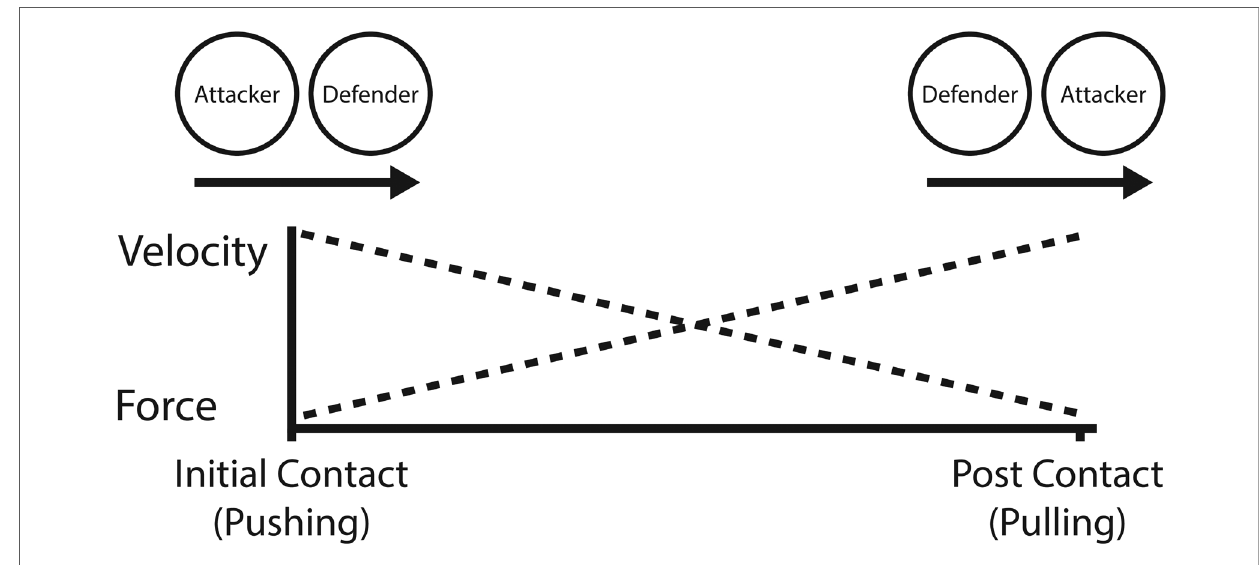
FIGURE 4 Hypothetical force and velocity demands during tackle